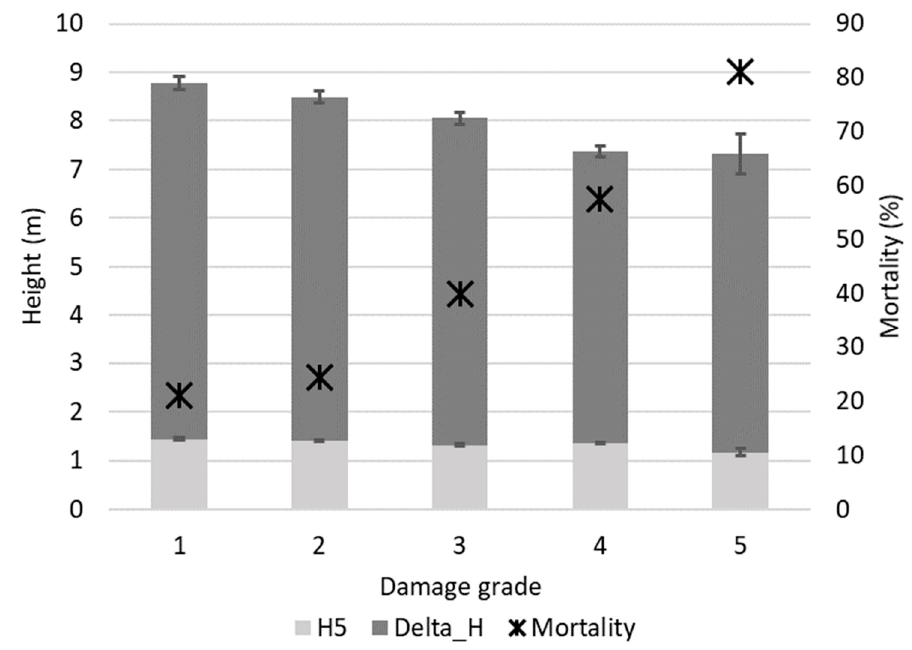
Figure 2. Tree height at the age of five years (H5), height increment between the age of 5 and 17 years (Delta_H), and mortality (%) between the age of 5 and 17 years. Whiskers denote 95% confidence interval.